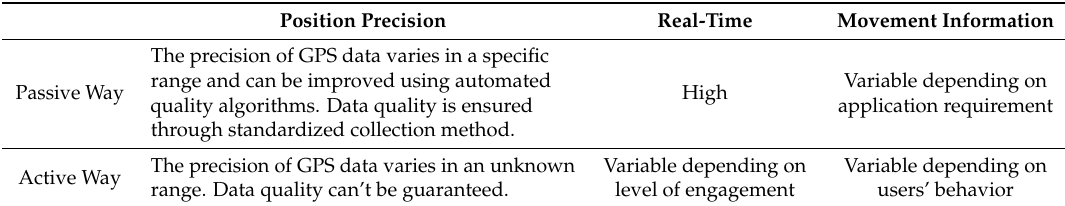
Table 1. The comparison of GPS data collected from different